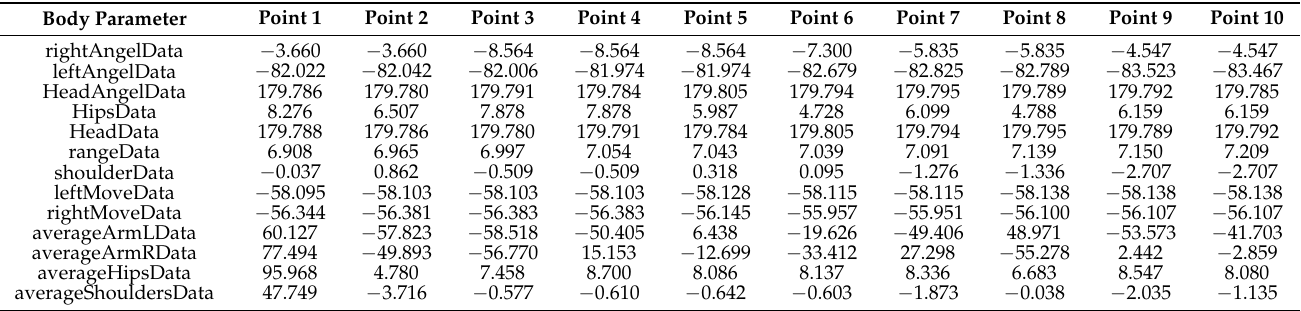
Table 5. Example of retrieved data